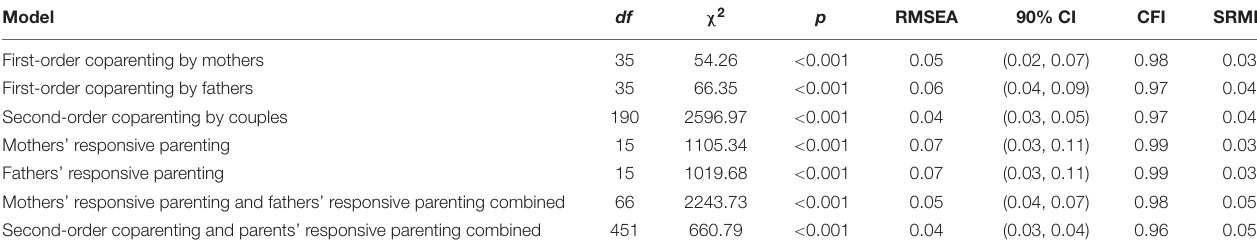
TABLE 3 | Fit indices of individual confirmatory factor analysis